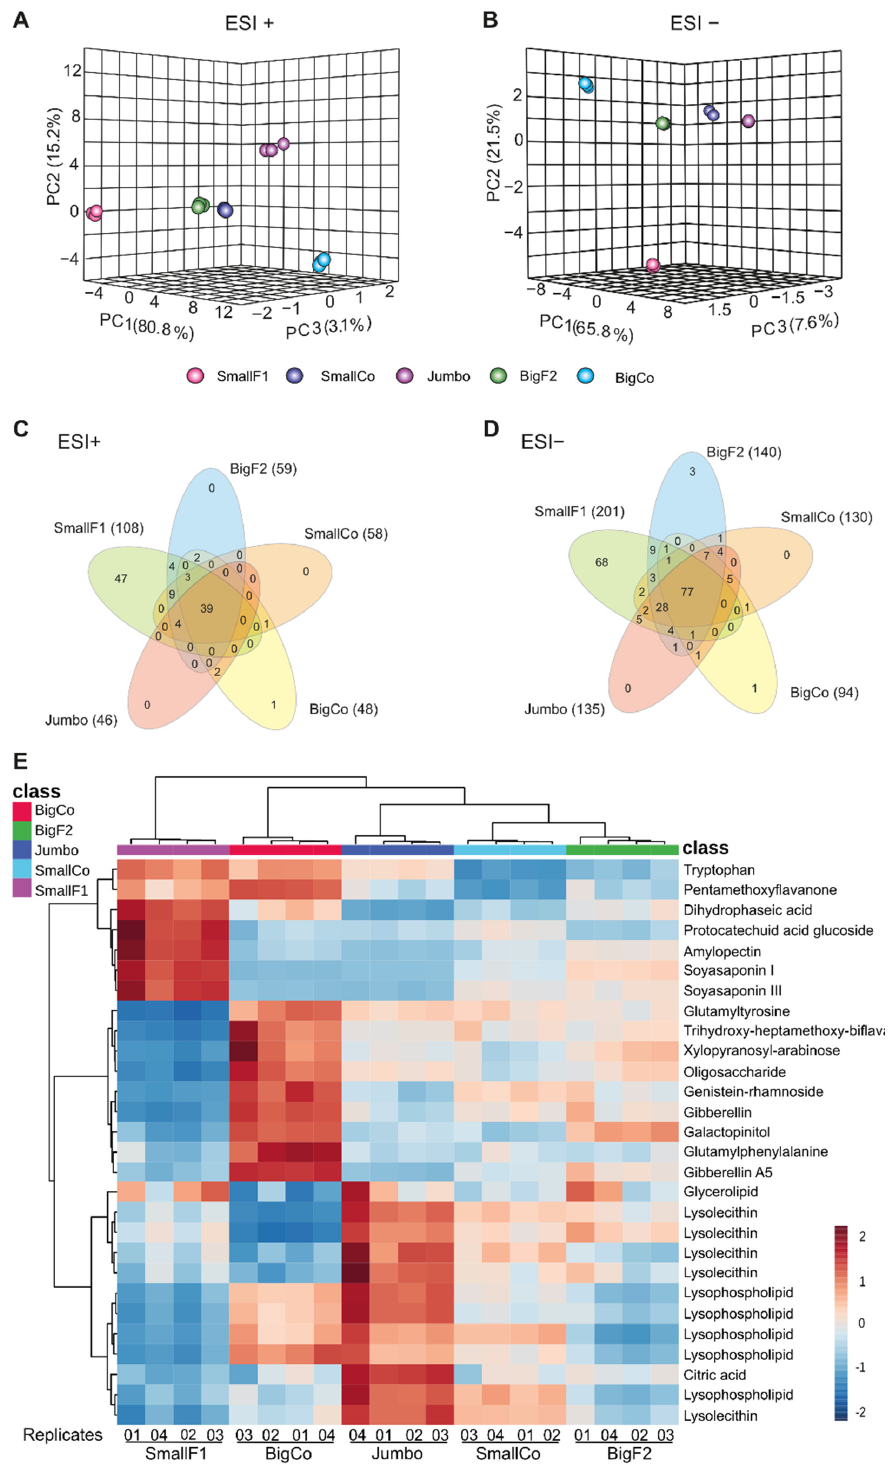
Figure 4. Three-dimensional principal component analyses performed with ESI positive ( A ) and negative ( B ) metabolome datasets. Venn diagrams performed with ESI positive ( C ) and negative ( D ) metabolome datasets. In ( E ), heatmap of the tentatively identified compounds of the core metabolome of studied chickpea